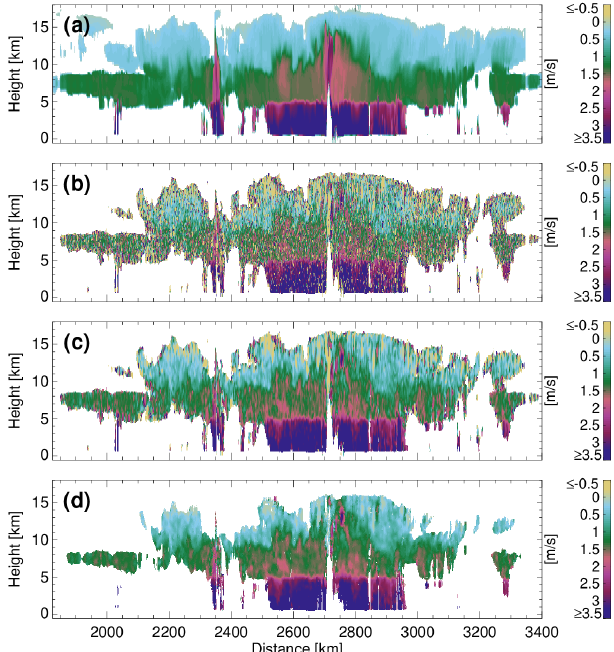
Figure 5. (a) The true hydrometeor sedimentation velocity from the GEM model for the Hawaii scene, (b) the raw, uncorrected CPR Doppler velocities, (c) 4km along track and 500m in the vertically integrated Doppler velocity and (d) the sedimentation velocity best estimate